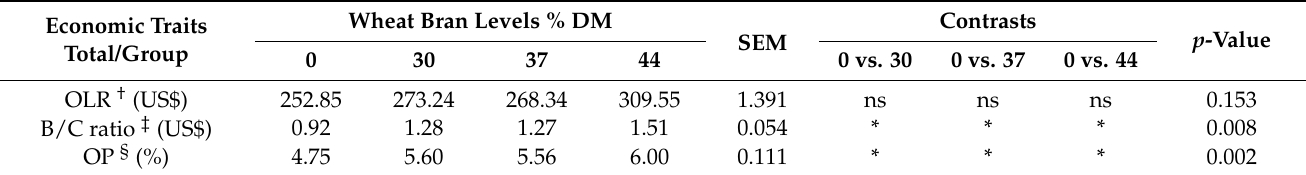
Table 10. Economic traits of lambs fed diets with cactus pear as the only forage source and levels of wheat bran. Economic